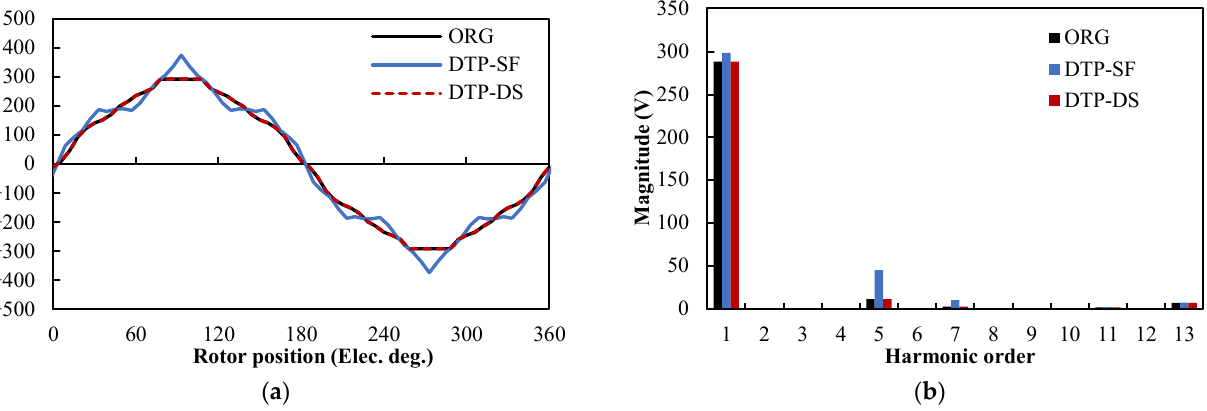
Rotor position (Elec. deg.)